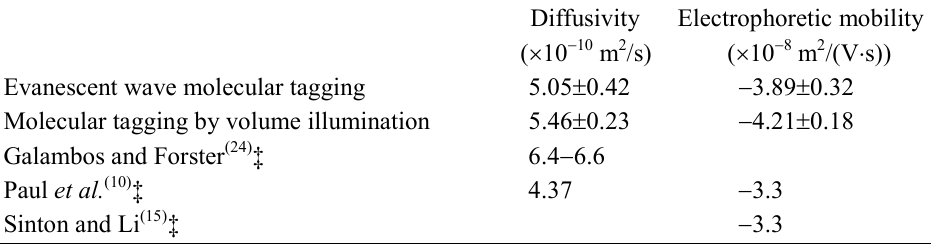
Table 2. Diffusivity and electrophoretic mobility of CMNB-caged